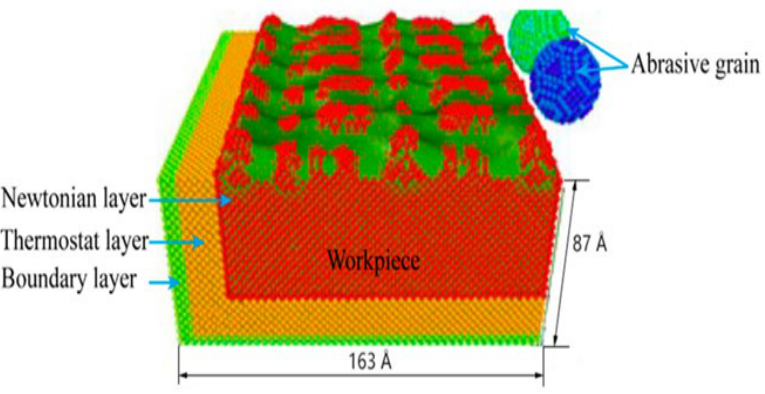
Figure 42. Numerical analysis model of boron nitride particles cutting [202].